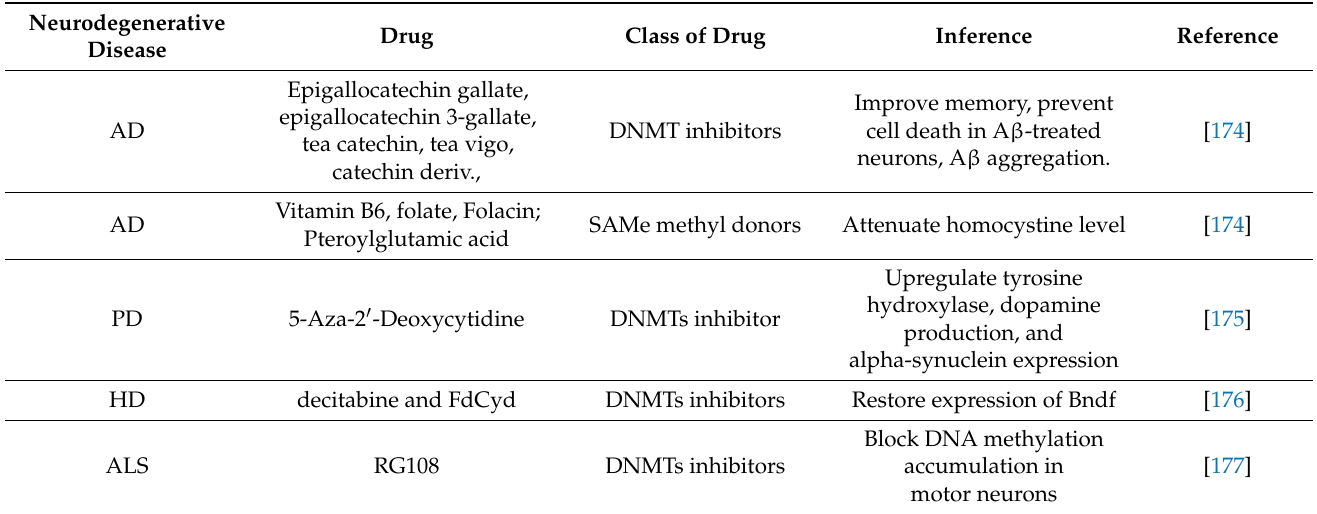
Table 3. Recent advances in the management of AD and other neurogenerative diseases by targeting DNA